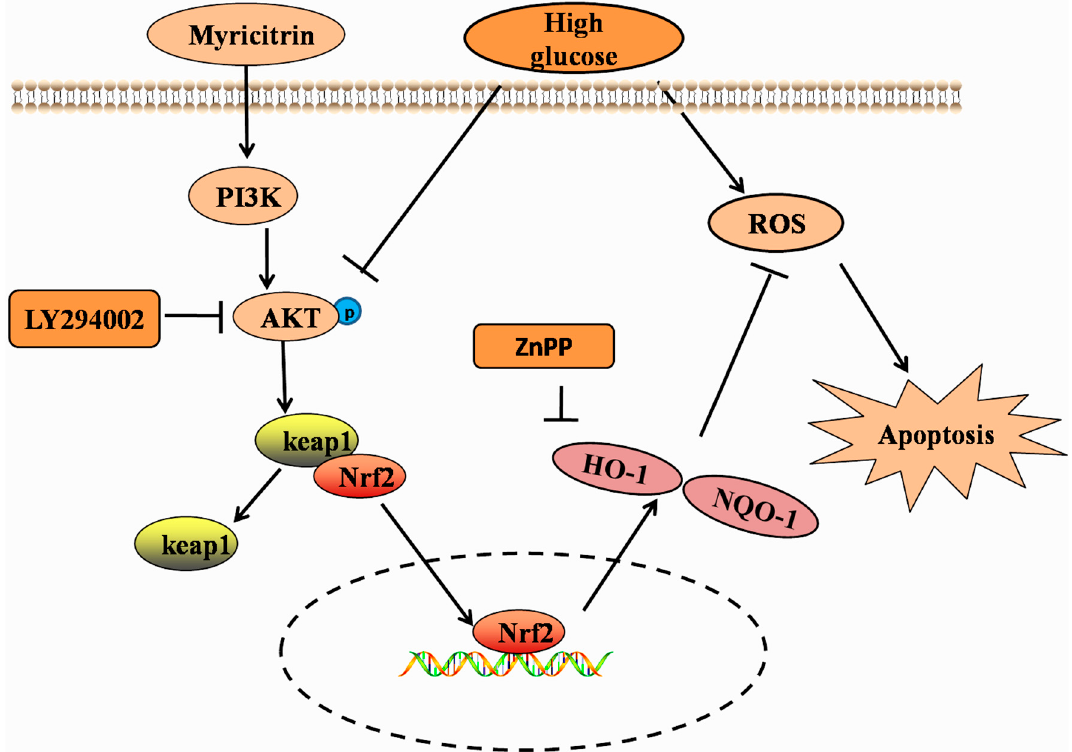
Figure 7. Schematic of the mechanism of myricitrin inhibition of HG-induced apoptosis via activation of PI3K/Akt signaling and up-regulation of HO-1 and NQO-1 in H9c2 cells.